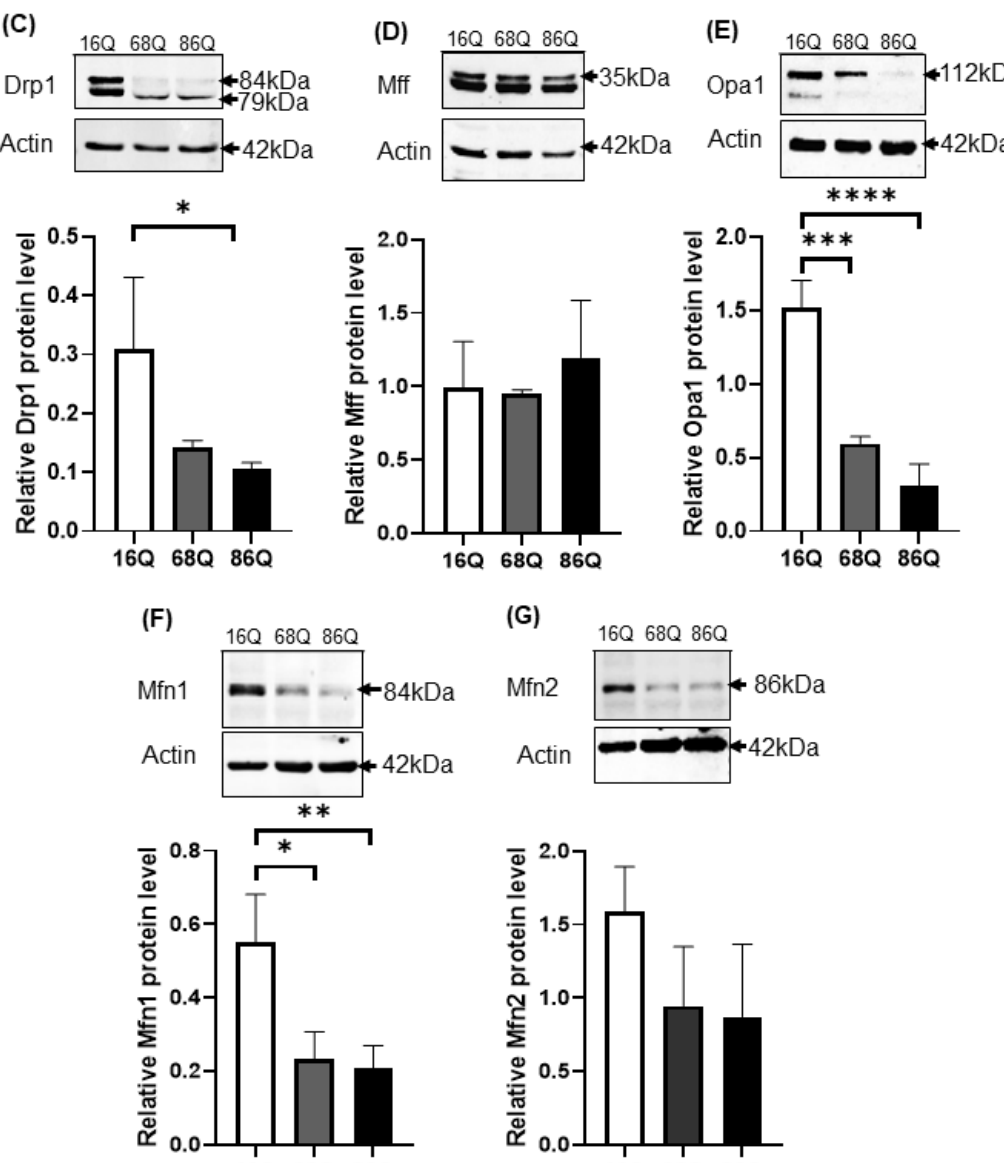
Figure 4. Altered gene and protein expression profile of the mitochondrial fusion–fission machinery in HD fibroblasts. ( A ) The mRNA levels of mitochondrial fission and fusion genes were examined by qPCR. The mRNA levels of HD (68Q and 86Q) fibroblasts were normalized to the healthy (16Q) control. Data are presented as mean values ± SD and represent three independent experiments. Statistical analysis was performed using ANOVA test by GraphPad Prism 8.2.1 (* indicates p < 0.05, ** indicates p < 0.01, *** indicates p < 0.001). ( B ) Representative, merged immunofluorescence confocal images showing the mitochondrial structure using 50 nM Mitotracker Red CMXRos, the mitochondrial fission protein Drp1 with an anti-Drp1 antibody / Alexa Fluor 488 and DAPI to stain the cell nuclei in healthy and juvenile HD fibroblasts. ( C – G ) Levels of mitochondrial fusion and fission proteins were examined by SDS-PAGE and Western blot analyses. Protein (20 µ g) from total cell lysates were loaded onto SDS-PAGE and transferred to nitrocellulose membrane for Western blot analyses. Actin was used as an internal loading control. Normalized mitochondrial fusion–fission protein levels in HD (68Q and 86Q) fibroblasts were compared to the healthy (16Q) control. Data are presented as mean values ± SD and represent three independent experiments. Statistical analysis was performed using ANOVA test by GraphPad Prism 8.2.1 (* p < 0.05; ** p < 0.01, *** p < 0.001 **** p < 0.0001).